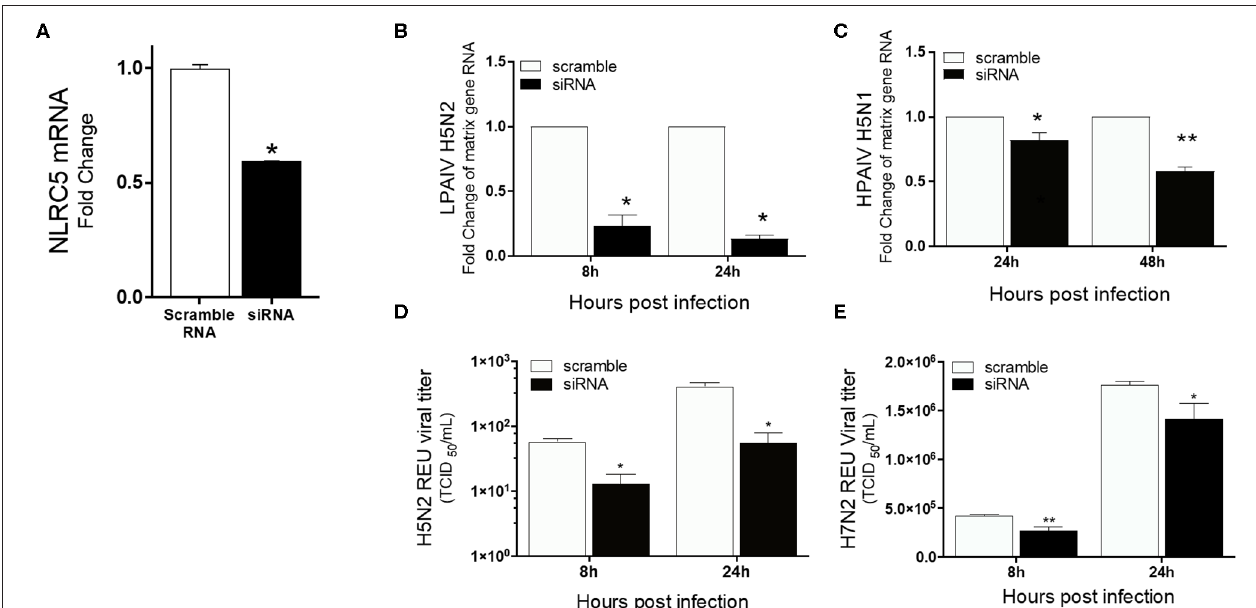
FIGURE 4 | Reduced virus titers of LPAIV and HPAIV in NLRC5 KD chicken macrophages. MQ-NCSU cells were transfected with NLRC5 siRNA or non-specific control siRNA (scramble) and infected with H5N2, H7N2 or H5N1 at 32 hpt. NLRC5 mRNA and viral RNA were quantified by qRT-PCR. (A) NLRC5 mRNA levels were measured at 32 hpt and compared to control. Viral RNA levels were measured by M-gene amplification at 8 and 24 hpi with (B) H5N2 and (C) H5N1. Supernatant infectious virus production was measured using relative equivalence units (REUs) at 8 and 24 hpi with (D) H5N2 or (E) H7N2. Data represents average of three biological replicates with error bars showing standard deviation. * p ≤ 0.05, ** p ≤